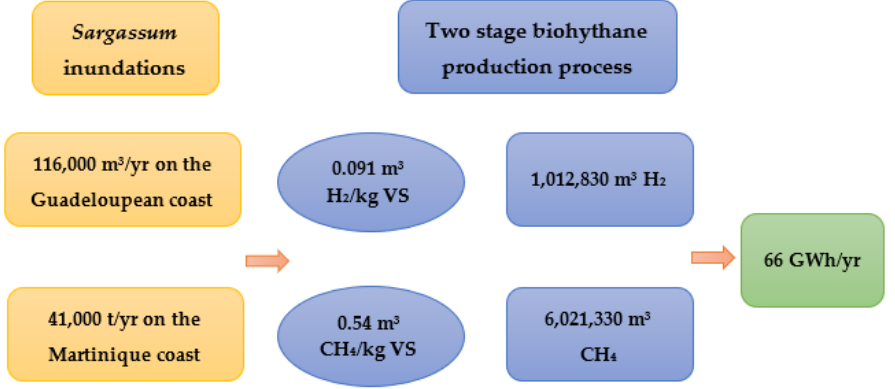
Figure 9. Potential energy generation through a two ‐ stage biohythane production (adapted from